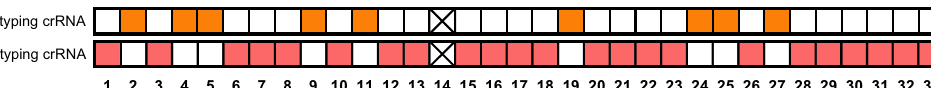
Fig. 3 | Adapting the PCR-LwCas13a assay for determination of Treponema pallidum lineage. a Schematic of PCR-LwCas13a assay for determination of TPA lineage. b – d Fluorescence measurementof Nicholsand SS14clade strainsby PCR- LwCas13a-based genotyping. e Dilution experiment to assess the limits of detec- tion of the tp0548 -based PCR-LwCas13a genotyping assay. f Ten skin biopsy sam- ples and their corresponding rabbit-passaged TPA isolates were genotyped using the PCR-LwCas13aassayand Sanger sequencing.The phylogenetictree for tp0548 sequenceswasconstructedusingMEGA-X.Thetreescalebarindicatestheaverage